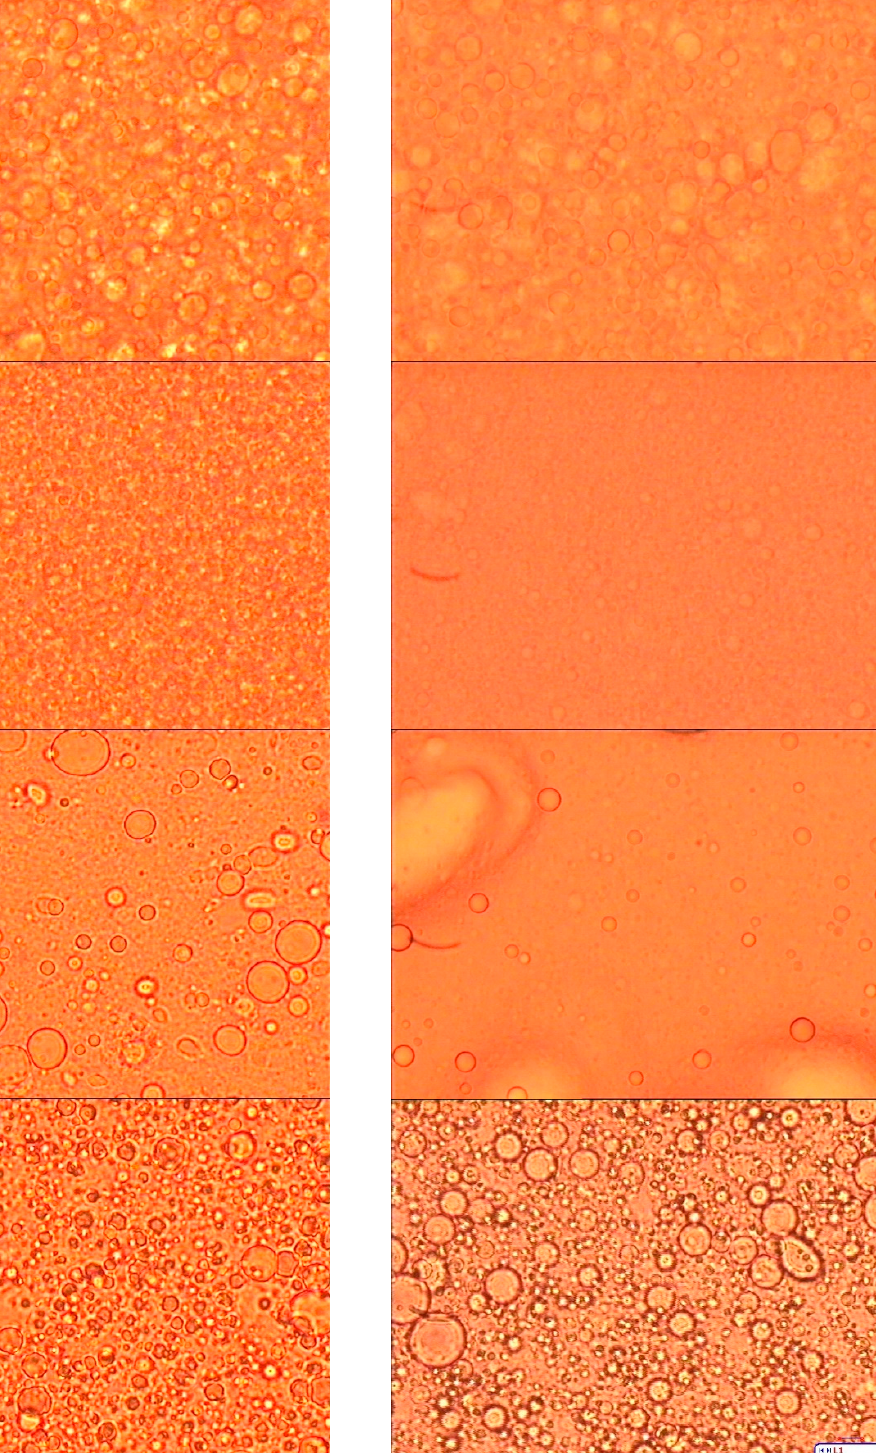
Figure 1. Emulsion micrographs at T0 and T28 days (at ×630 magnification). The viscosity of each emulsion was measured at a shear rate (SR) of 0.02 s − 1 , apart from emulsion 3T, which, given the low viscosity of the samples, had to be measured at a SR of 25 s − 1 . Table 3 reports the average viscosity for each emulsion type. There is a clear difference in the viscosity values taken at T0 and T28 for all the manually emulsified preparations (variation > 20%). Conversely, the viscosity remained constant over time for the